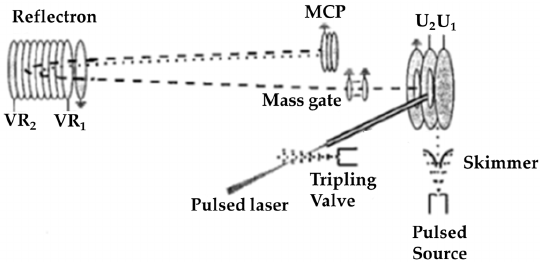
Figure 11. Schematic overview of the molecular beam photoionization reflectron TOF mass spectrometer used by Jongma et al. Figure adapted from [48] with permission. Copyright 1998 American Chemical Society.